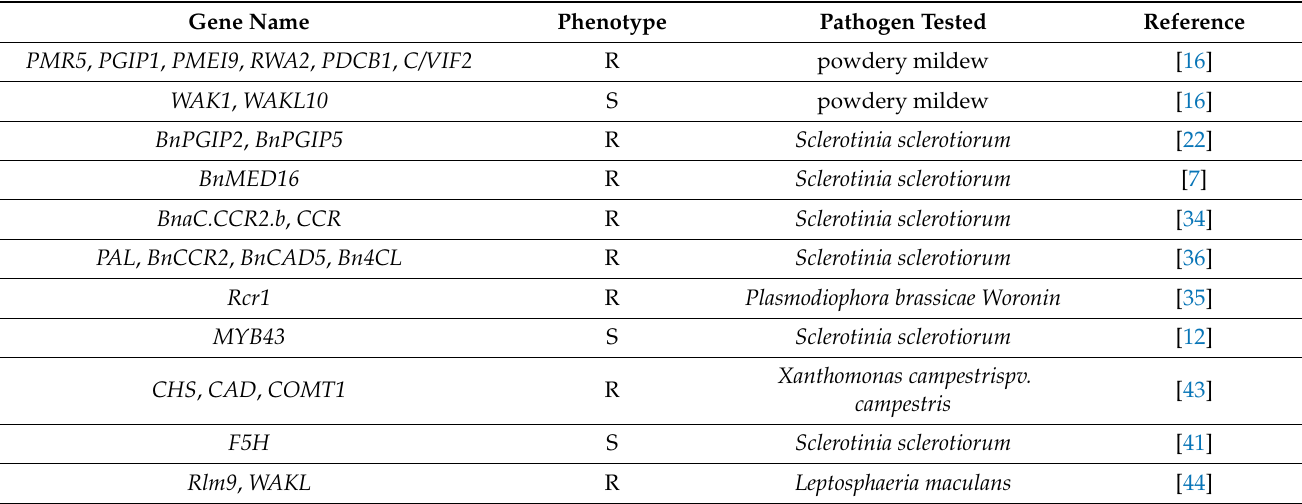
Table 1. Selected genes related to cell-wall-mediated immune responses in B. napus